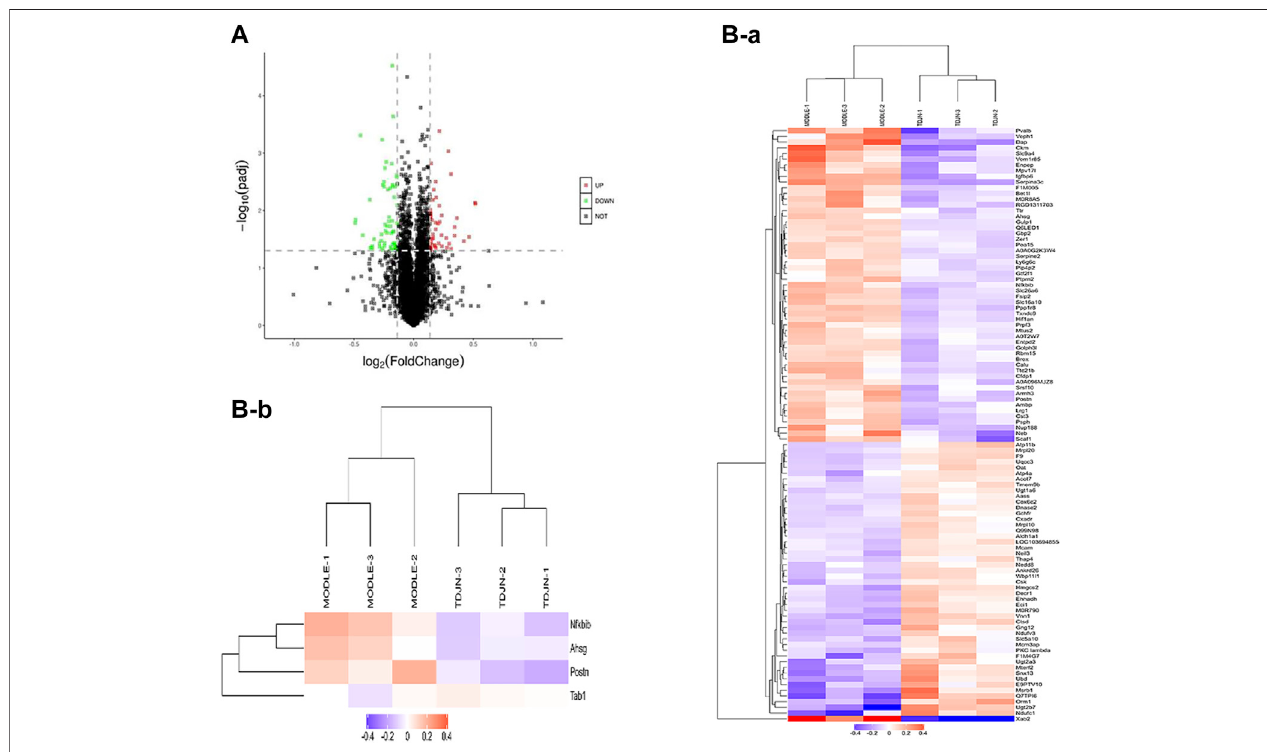
FIGURE 4 | Pharmacoproteomics of SHR kidneys after TDC treatment (A) Volcano plot illustrating proteins with different abundance in model and TDC treatment groups.TheLog2ratiosofproteinintensitiesofTDCtreatmenttotheControlgroupwereplottedagainstthenegativeLog10 p values.Redpointsrepresentupregulated proteins while green points represent downregulated proteins in the TDC treatment group (fold change > 1.1, p -value < 0.05), and gray points represent unchanged proteins (B) Clustering of the differentially expressed proteins. The changed proteins were assigned to two clusters (a, b) by fuzzy c-means (FCM) clustering algorithm. The y -axis is log10 transformed and normalized. Each trace was colored according to its membership value in the corresponding cluster (referred to membership color bar).